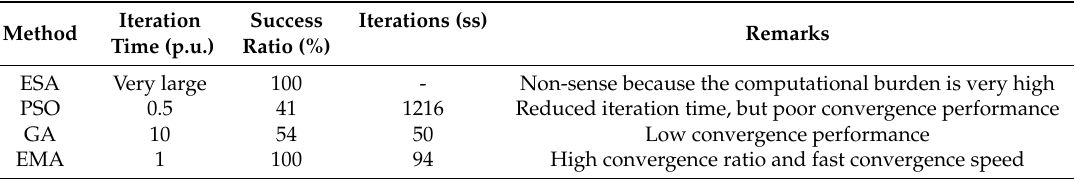
Table 2. Comparison of different optimization techniques to solve the SHM problem with seven switching angles (ss means successful